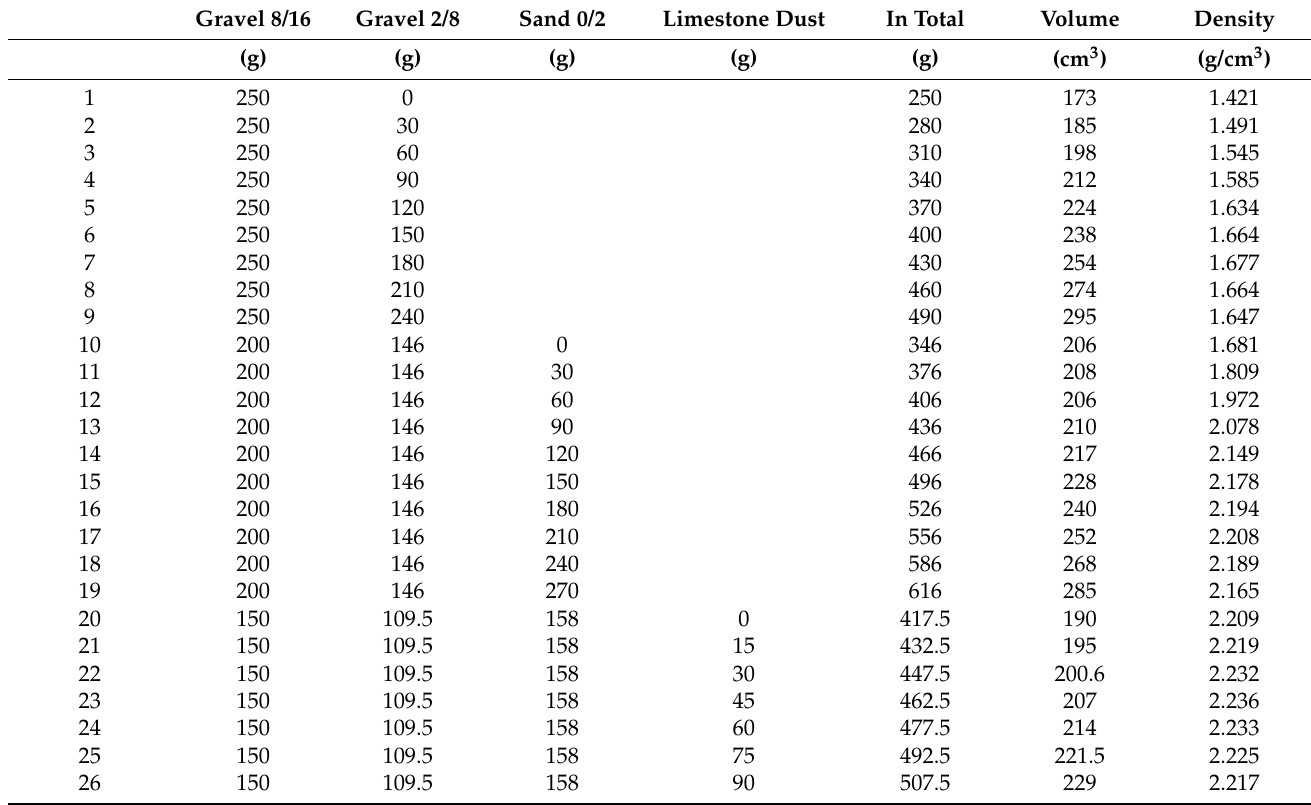
Table 7. The experimental selection of the